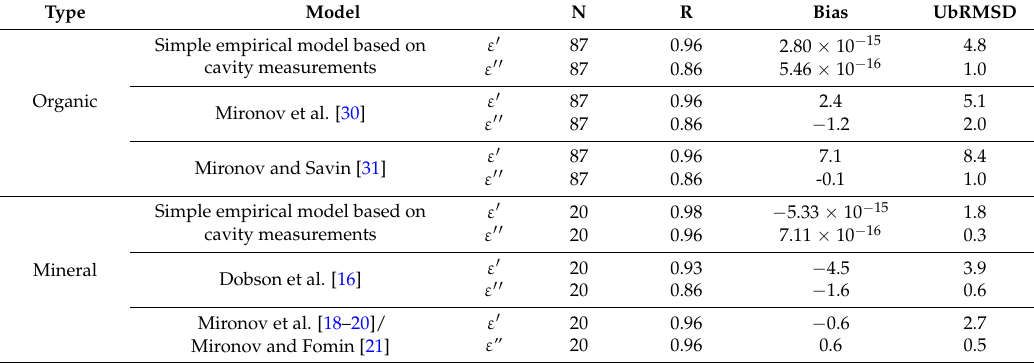
Table 4. Statistics for the simple empirical models fit through the resonant cavity datasets (real ε (cid:48) and imaginary ε (cid:48)(cid:48) parts of the relative permittivity) of all organic and mineral samples, respectively, as well as agreement of output of different dielectric models with the resonant cavity measurements: N = Number of datapoints, R = Pearson’s correlation coefficient, Bias = mean difference between expected and measured values, UbRMSD = bias-corrected root mean square